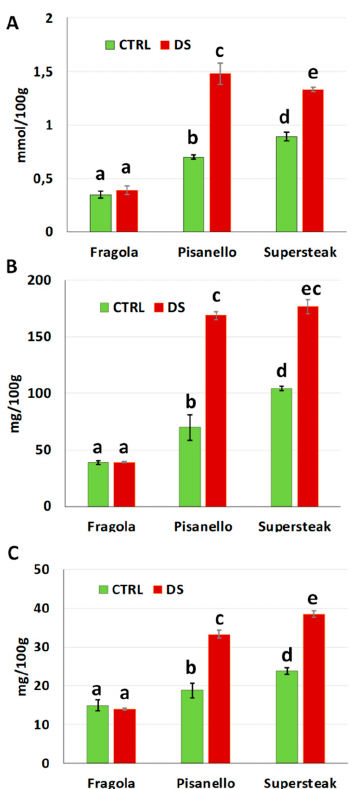
Figure 10 . Nitro Blue Tetrazolium (NBT) staining in leaves of two local varieties ( A